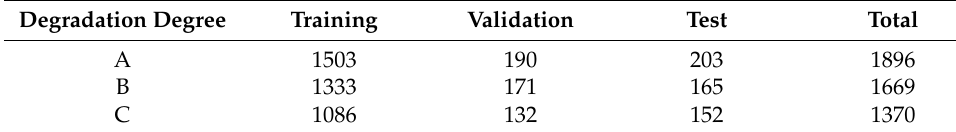
Table 4. Number of images in the distress type of concrete scaling. Degradation Degree